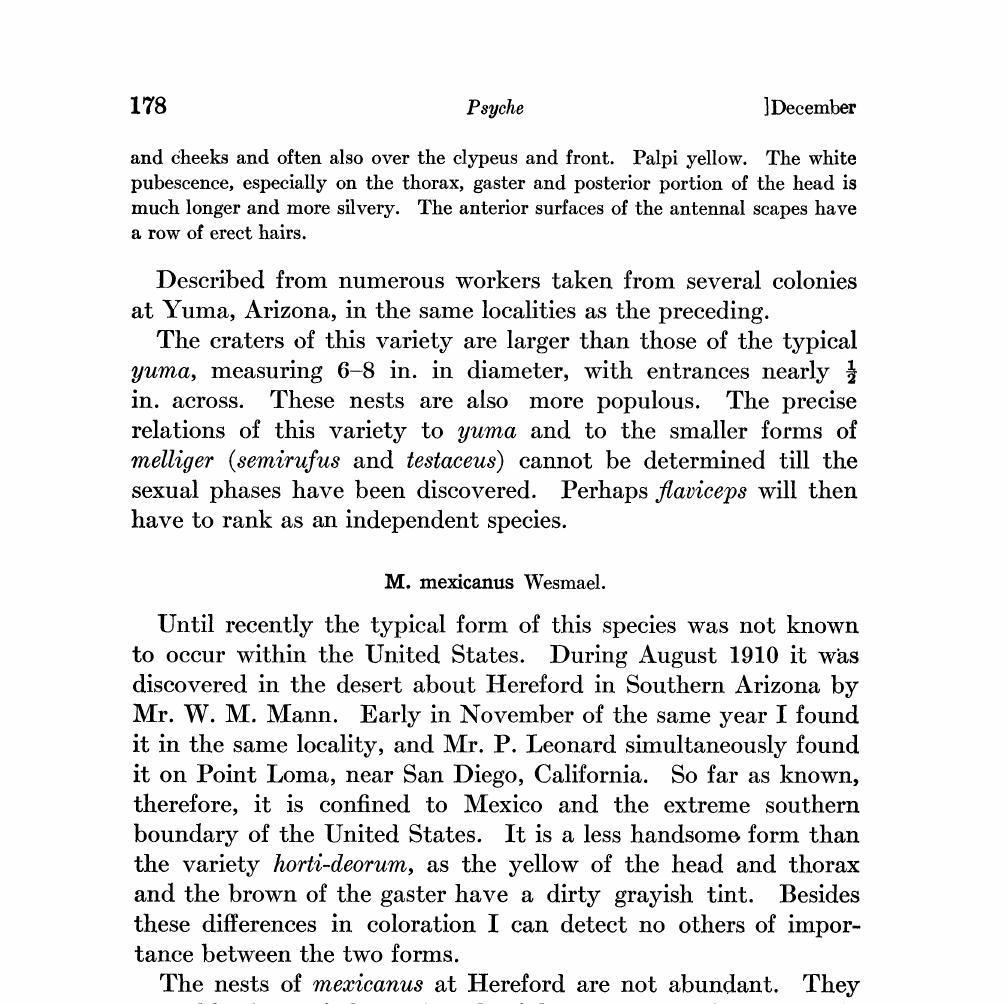
and (heeks and often also over the clypeus and front. Palpi yellow. The white pubescence, especially on the thorax, gaster and posterior portion of the head is much longer and more silvery. The anterior surfaces of the antennal scapes have a row of erect